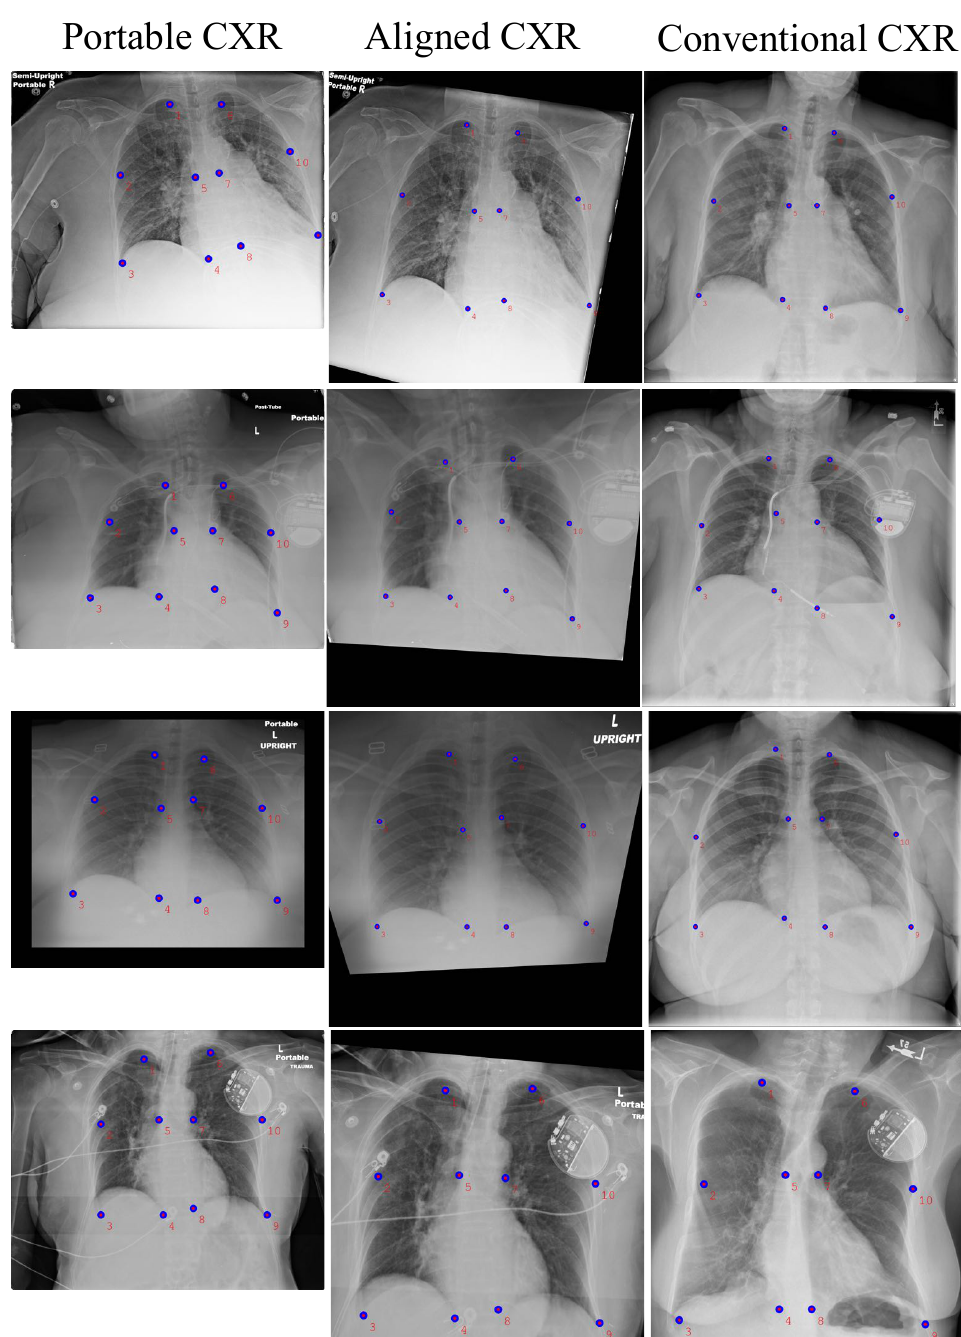
Figure 7. Some illustrations of our aligning results. From left to right—the first column: portable radiographs; the second column: aligned radiographs by our model; and the third column: conven- tional radiographs which are used for